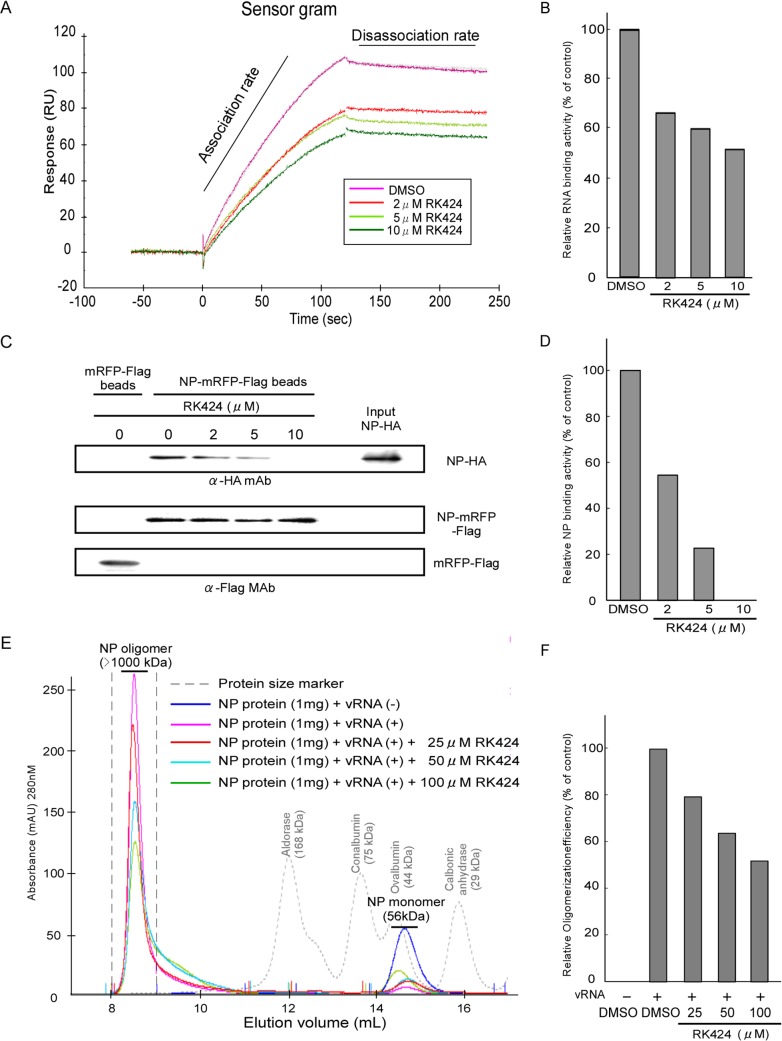
Effect of RK424 on the NP-RNA and NP-NP interactions, and on NP oligomerization.(A) Sensorgram showing the interaction between NP and RNA in the absence or presence of RK424. Two independent experiments were performed and one representative result is shown. (B) Quantification of RNA binding activity. (C) Purified NP-HA proteins were incubated with RK424 for 1 h followed by incubation with FLAG agarose beads coupled to mRFP-Flag (mRFP-Flag beads) or NP-mRFP-Flag proteins (NP-mRFP-Flag beads). Binding of NP-HA to mRFP-Flag or NP-mRFP-Flag beads and the input NP-HA were detected by western blotting with an anti-HA MAb. The amount of protein bound to FLAG agarose beads was detected with an anti-Flag MAb (loading control). Three independent experiments were performed and one representative result is shown. (D) Pull-down assay to examine NP binding activity. (E) Purified NP proteins were pre-incubated with RK424 followed by incubation with vRNA synthesized by in vitro transcription. The incubated samples were injected onto a Superdex 200 Increase size exclusion column. The integrated peaks between and elution volume of 8 mL and 9 mL were evaluated to measure the oligomerization rate of NP. Two independent experiments were performed and one representative result is shown. (F) Oligomerization rate of NP as assessed by size exclusion chromatography.